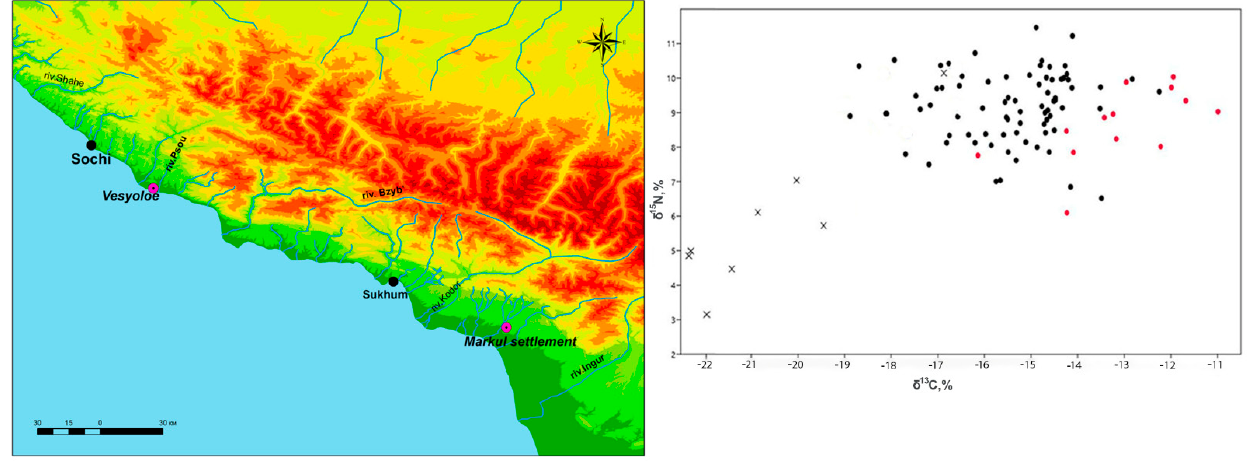
Figure 8. Maps and isotopic indicators of nitrogen and carbon: comparison of data from the village of Vesyoloe (black dots) and the Markul settlement (red dots), and samples of animals (crosses).